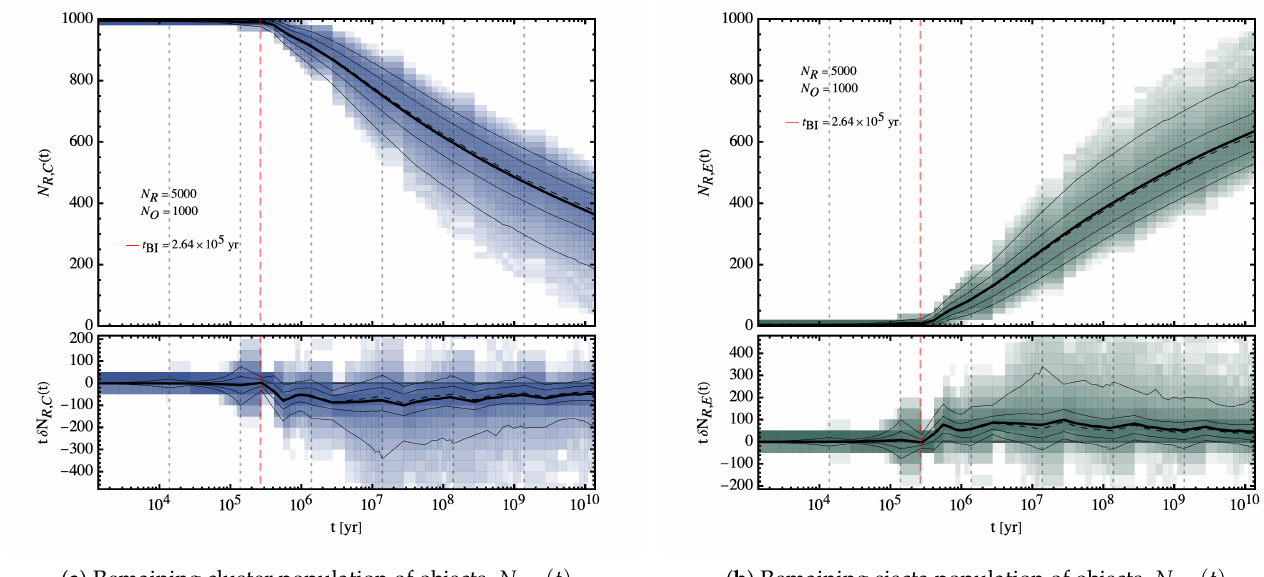
Figure 8. Top: Total population of remaining cluster and ejecta objects in blue and teal, respectively; N R, X ( t ) , where X = C,E. The thick black line mark the mean of the discrete distribution of evolution trajectories per snapshot, while the thin black line in the same panel represents the median. Bottom: Differential of the total population of remaining cluster/ejecta objects, ( t ) where X = C,E. The thick black line or loss/gain counts in between snapshots, rescaled by the simulation time, t δ N R, X 2 in the lower panels mark the mean differential counts, while the thin black line represents the median differential counts and the dotted black line corresponds the B i coefficient of the logarithmic decrease/increase, or alternatively, the mean differential counts themselves. All: The darker and lighter regions represent the 68% and 95% C.B. of each individual evolution of the cluster and ejecta populations for all N R = 5000 realisations. The dotted vertical grey lines separate the N r = 7 consecutive runs, and the dotted vertical grey line signals the burn-in